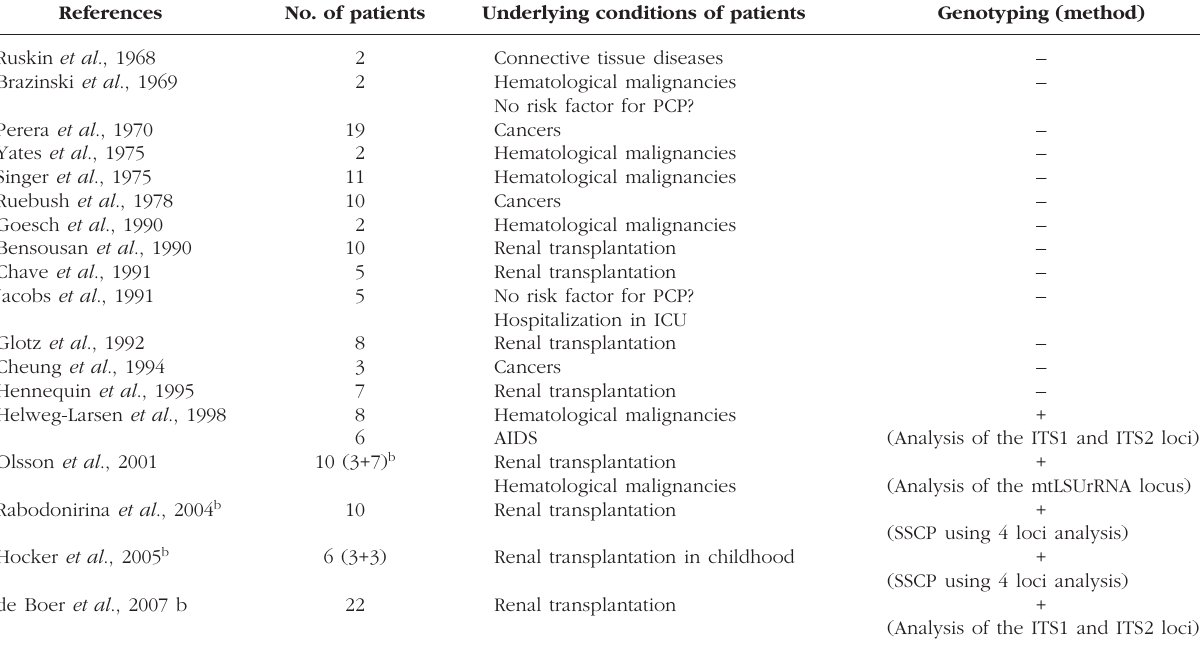
Table I. – Main clusters of Pneumocystis pneumonia in hospitals that were reported over the past five